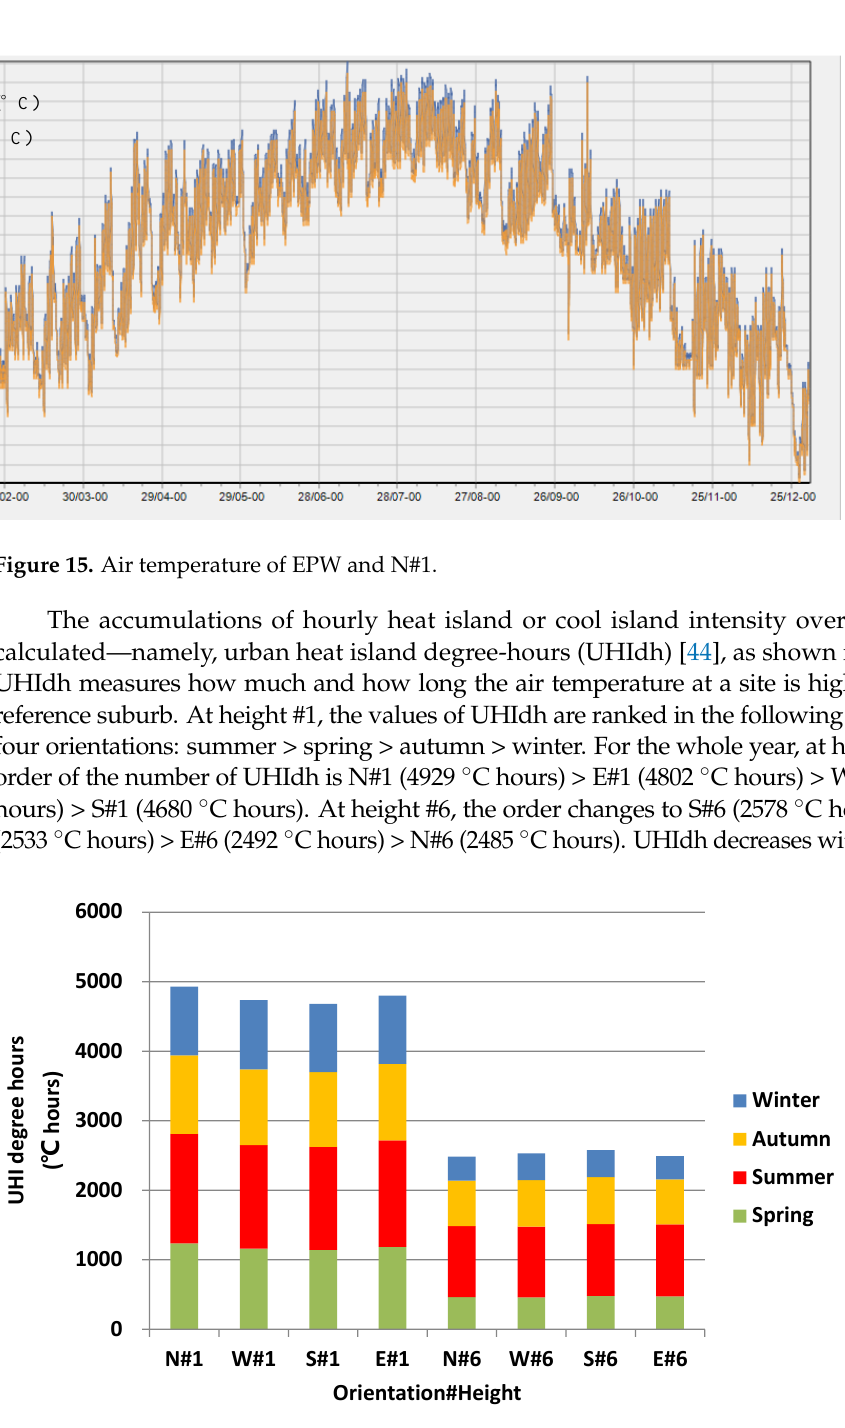
Figure 16. UHI degree-hours of four orientations at the height of 3 m and 103 m for four seasons.